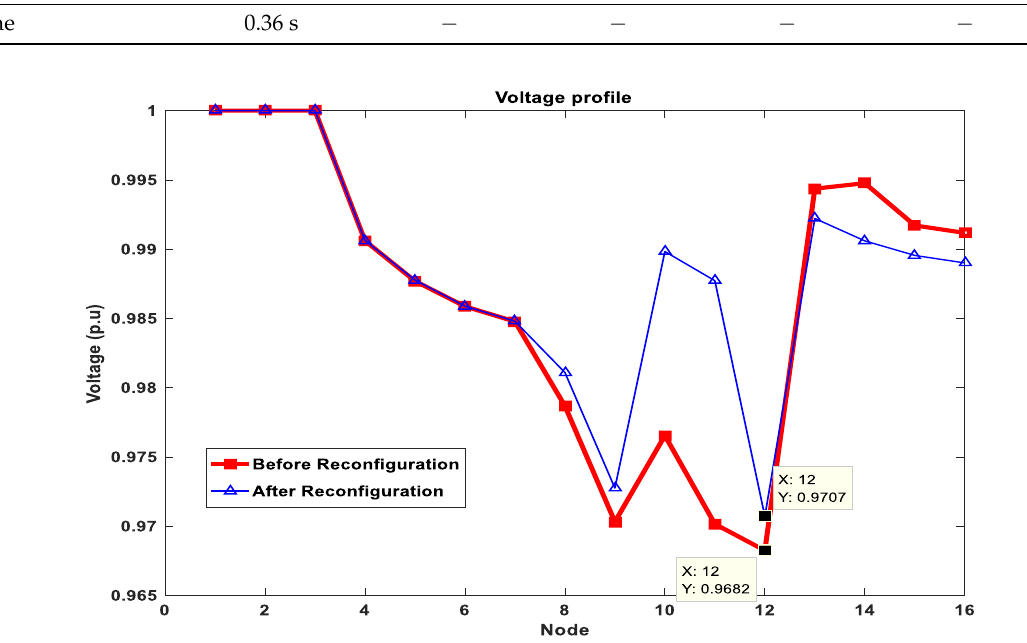
Figure 3. The voltage profile of the 16-bus network before and after feeder reconfiguration.